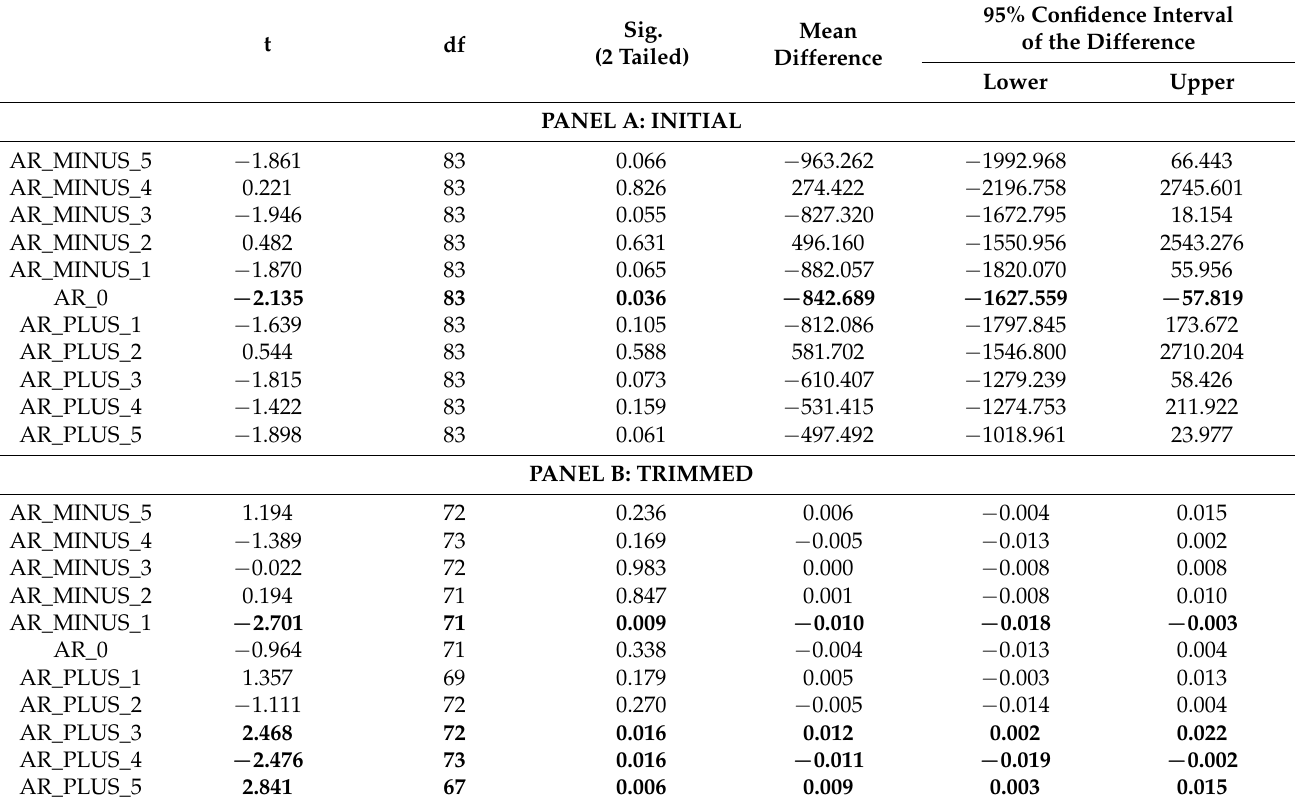
Table 5. t -test for mean difference of daily abnormal returns from day − 5 to day